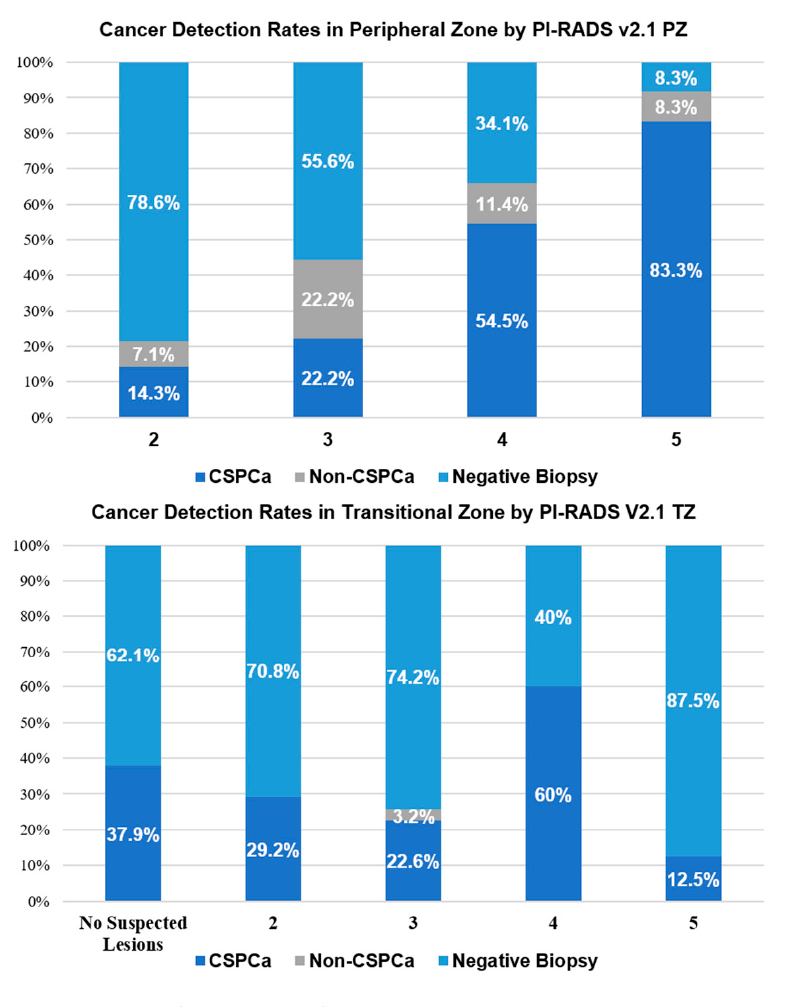
Figure 2. CSPCa detection rates by PI-RADS v2.1 scores.